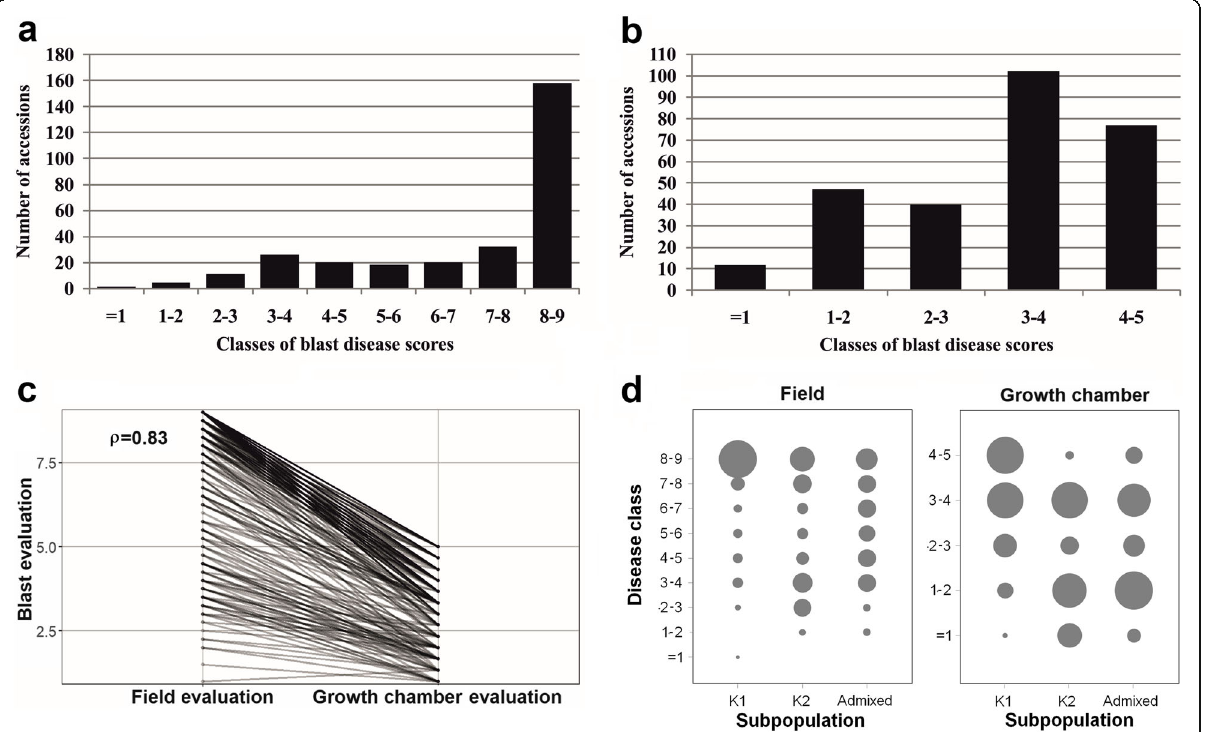
Fig. 1 Blast evaluation of the GWAS panel. a Frequency distribution of infection types in the field evaluation (1 – 9 SES scale; International Rice Research Institute (IRRI) 1996. Lower values correspond to higher resistance); b Frequency distribution of infection types after growth chamber inoculation with a mix of the three blast isolates (1 – 5 scale by Faivre-Rampant et al. 2011; as above); c Reaction norm between the two infection conditions; Pearson correlation coefficient ( ρ ) is indicated; d Distribution of blast resistance scores of the panel in the three